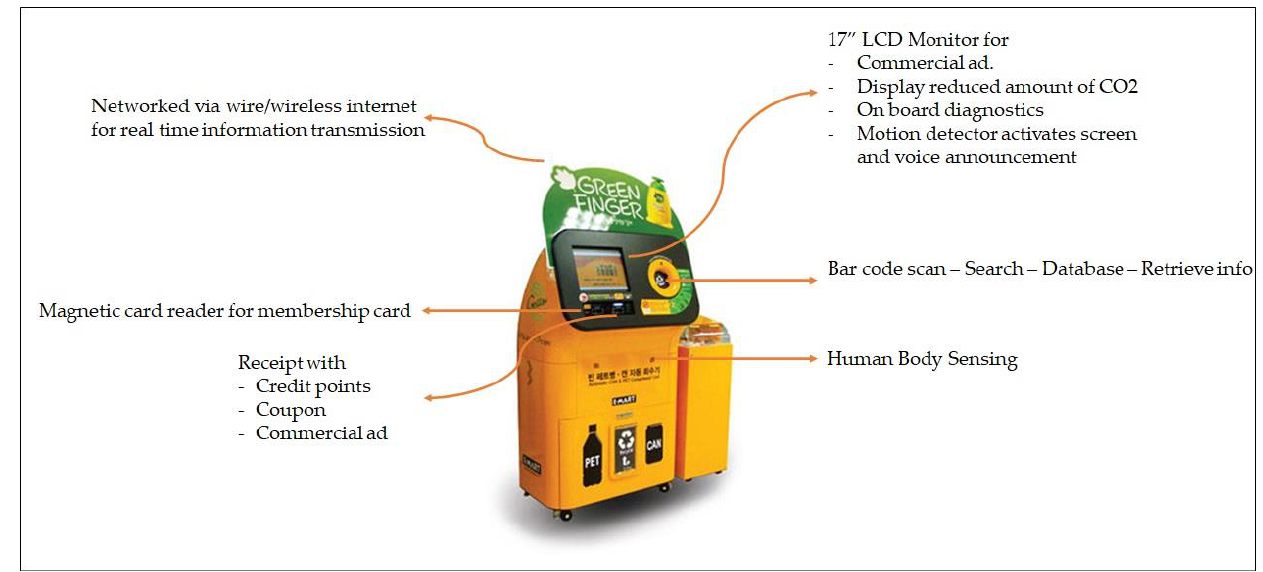
Figure 8. Dr. Boomerang by Ecosave.